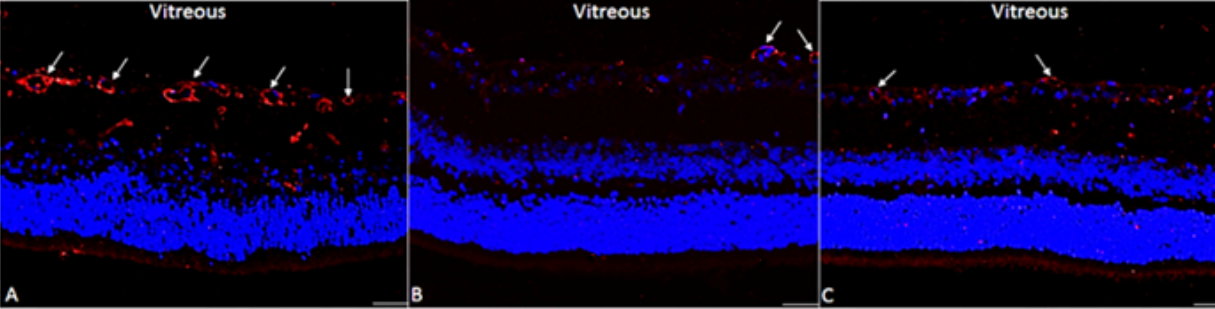
Figure 3. Intravitreally injected reduced Col4-endothelial cell staining at the superficial mice retina. Retinal immunofluo- rescent micrographs showing Col4 immunolabeling in red. ( A ) CRO intravitreally injected failed to reduce pathological angiogenesis at the retina, these retinas presented augmented number of endothelial cells at the retinal surface, the sprouting neovessels were localized at the vitreous infiltrating through the ILM (white arrows). Extra-retinal neovascularization was characterized by neovessels protruding to the vitreous similar to PDR. ( B ) AS1411 reduced Col4 immunolabeling signal at the retina, hence AS1411 reduced the number of endothelial cells in the retinal ILM near to the vitreous. ( C ) Similarly, to AS1411, ranibizumab treatment reduced immunolabeling signal of Col4-endothelial cells, indicating lower pathological angiogenesis at retinal surface in comparison to the inactive CRO aptamer treatment. These are representative micrographs of 5 independent assays. Nucleus were DAPI (Blue) stained. Bar = 20 μ m.